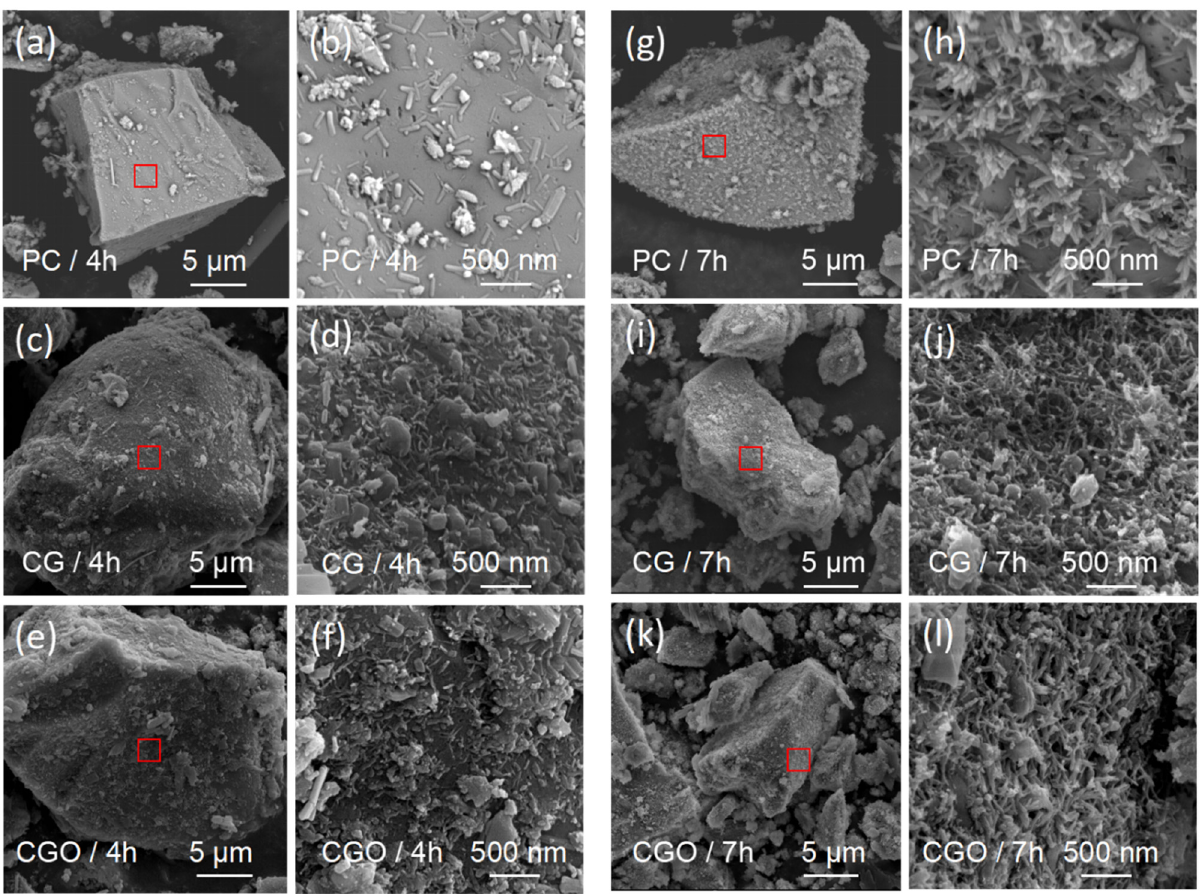
Figure 4: Morphology of hydration products on the surface of cement particles at 4 h in PC ( a and b ) , CG ( c and d ) , CGO ( e and f ) , and at 7 h in PC ( g and h ) , CG ( i and j ) , CGO ( k and l )